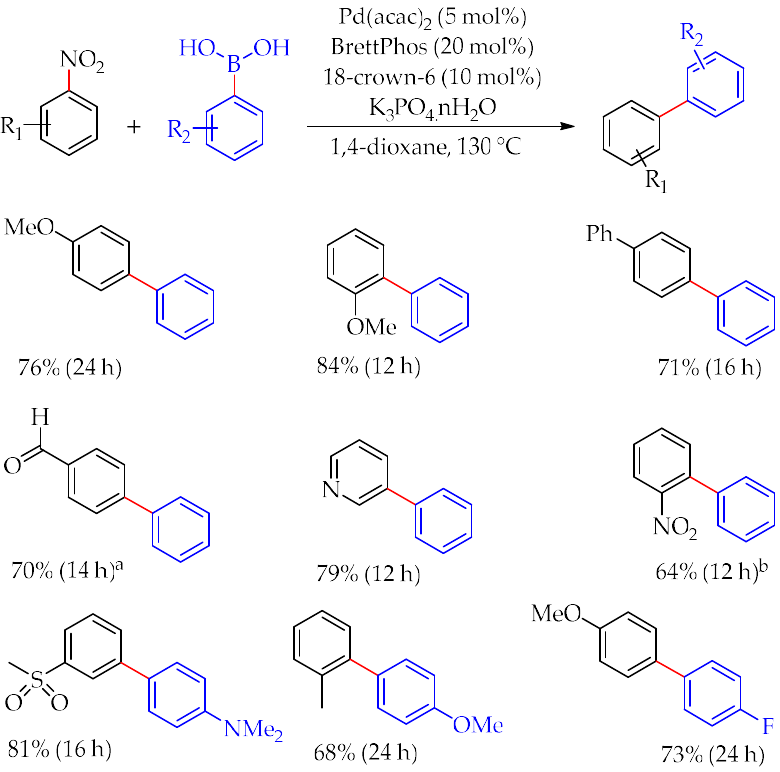
Table 1. The Suzuki–Miyaura coupling (SMC) of nitroarenes with various substrates ( a Isolated yield after hydrolysis of the corresponding acetals. b Reaction with CsF) [24].